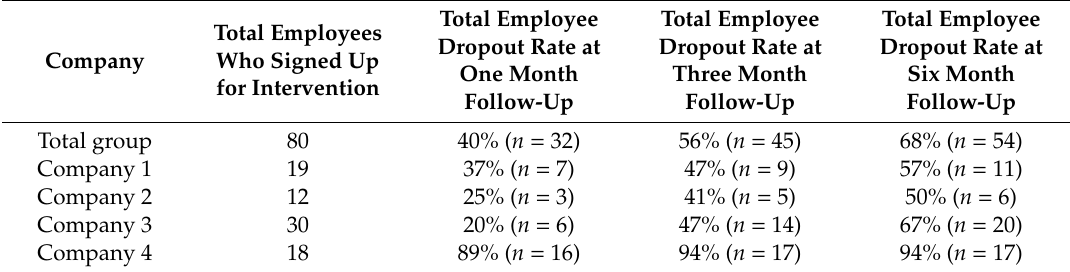
Table 5. Individual company dropout rate.